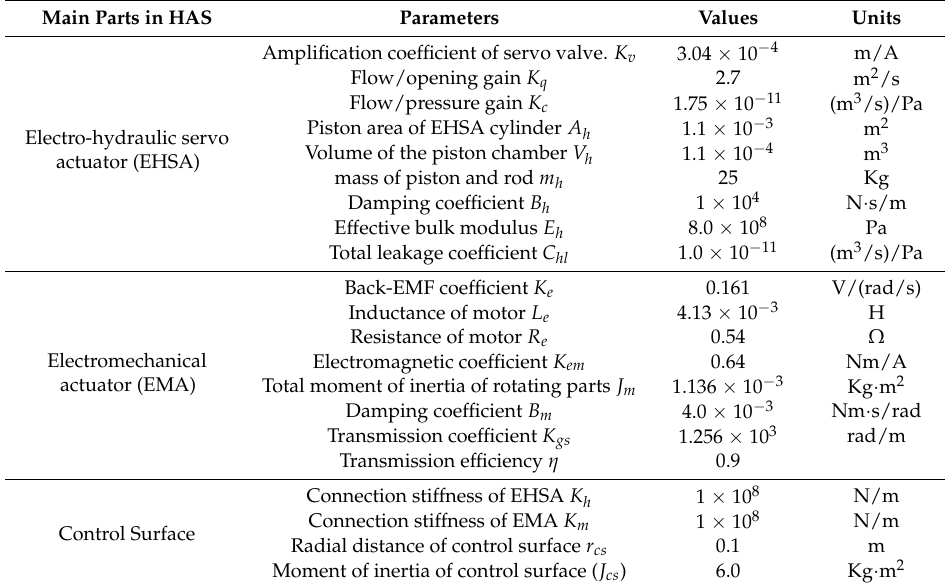
Table 1. The parameters of hybrid actuation